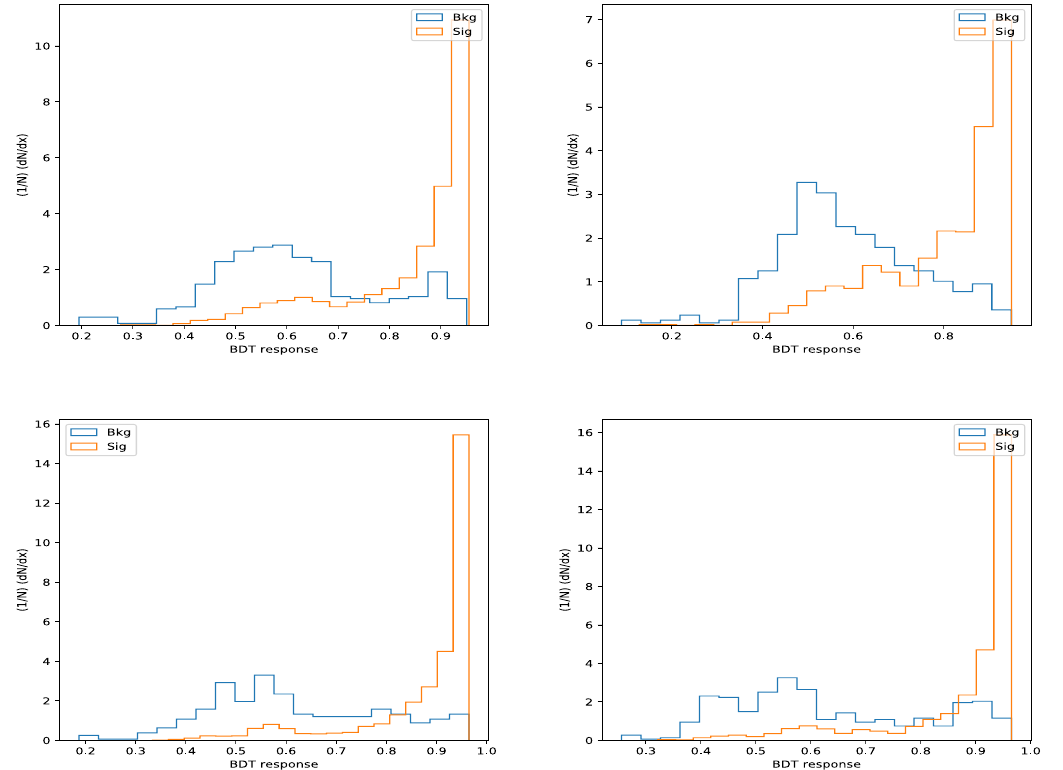
Figure 18 . BDT classifier response for different benchmark points of vector boson fusion for Type I BP I (top left), Type I BP II (top right), Type II BP I (bottom left) and Type II BP II (bottom